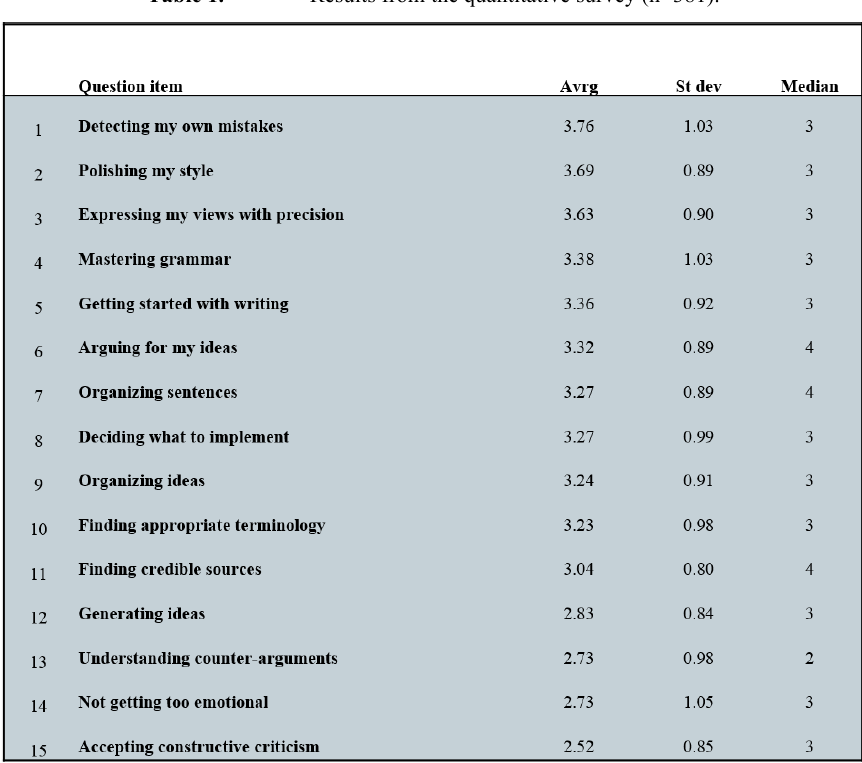
Results from the quantitative survey